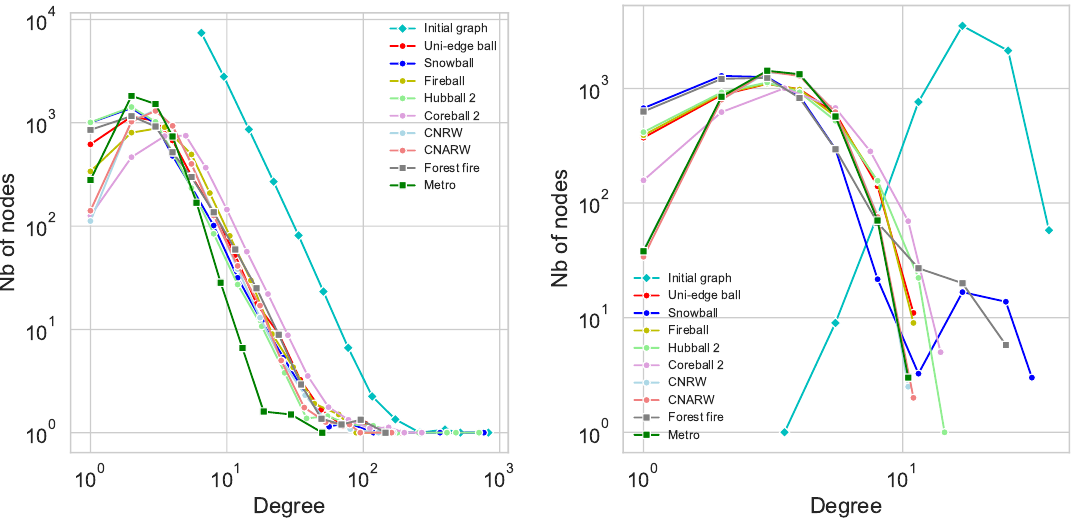
Figure 2. Degree distribution for different sampled graphs on Barabási-Albert (left) and Erd˝os-Renyi (right) random graphs. The sampling reduces the graph to 10% of its original size (50k nodes). The curve corresponding to the initial graph (not sampled) is in cyan. The different samplings provide close results. The slope is identical except for the Metropolis Hasting one, which is steeper for B-A and reaches a maximum shifted toward high degree nodes in